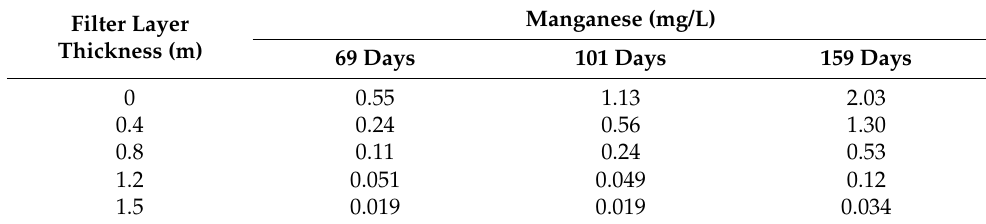
Table 6. Variations in manganese along the filter layer at different stages.